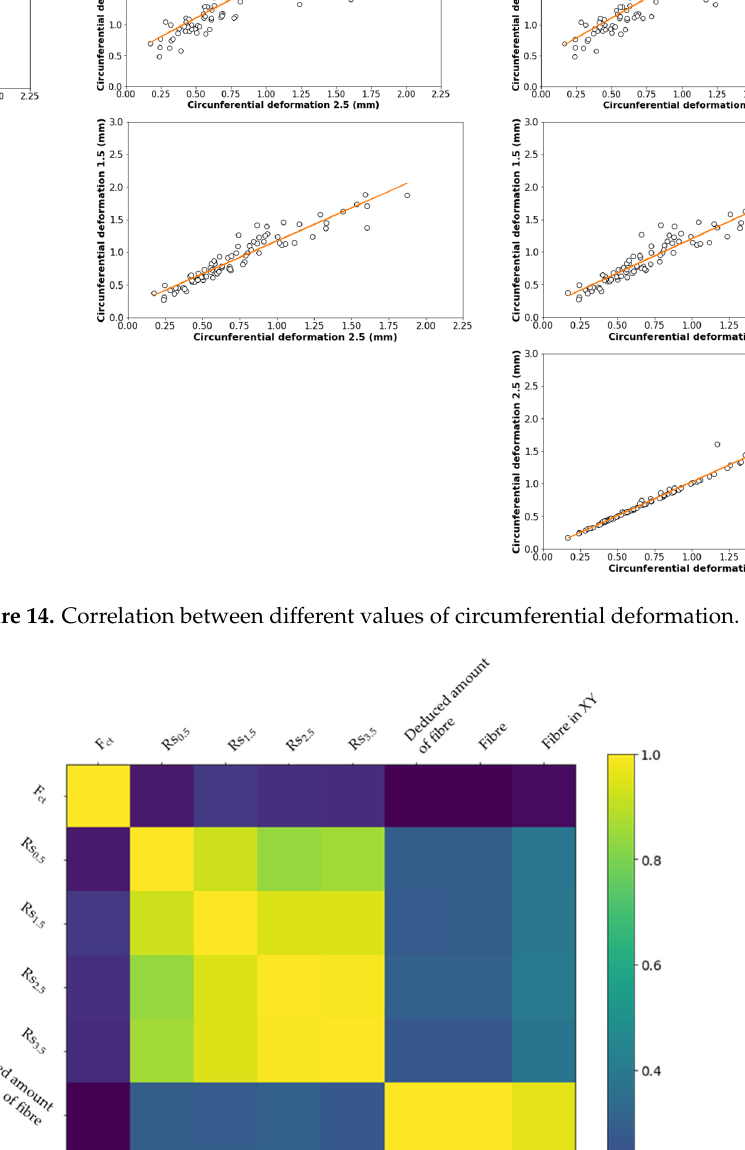
( b ) Figure 16. Amount of fibre in XY vs. circumferential deformations in BH-bottom ( a ) and BH-top ( b ). Figure 17 shows the correlation between circumferential deformation and fibre quan- tity in the XY plane for both types of pouring directions. 0.00.5 1.0 1.5